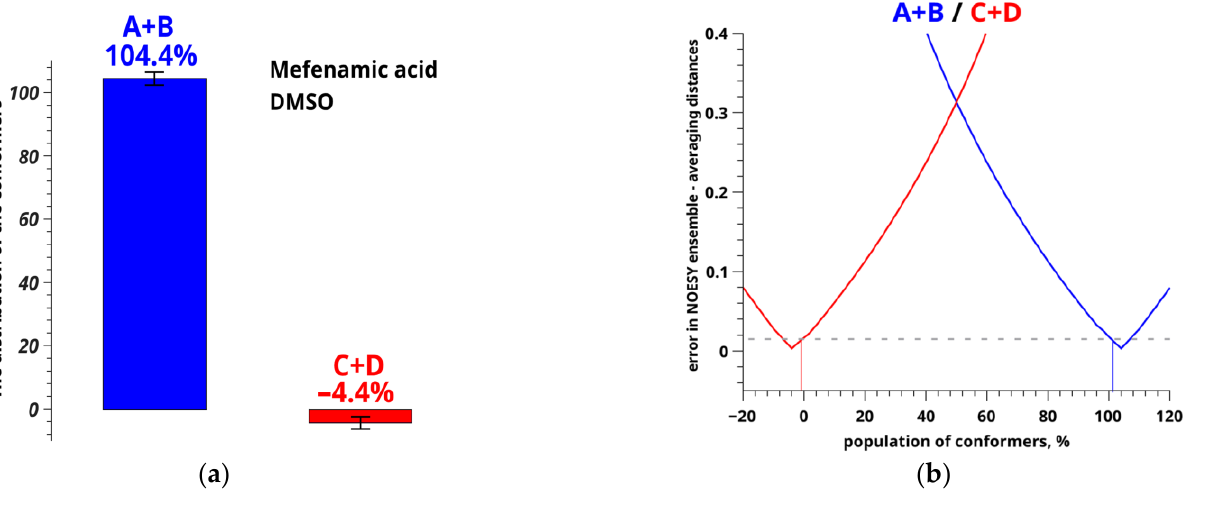
Figure 7. Distribution ( a ) and population ( b ) of conformers of MFA in DMSO-d 6 calculated from the observed conformation-dependent distance OH-H6. observed conformation-dependent distance